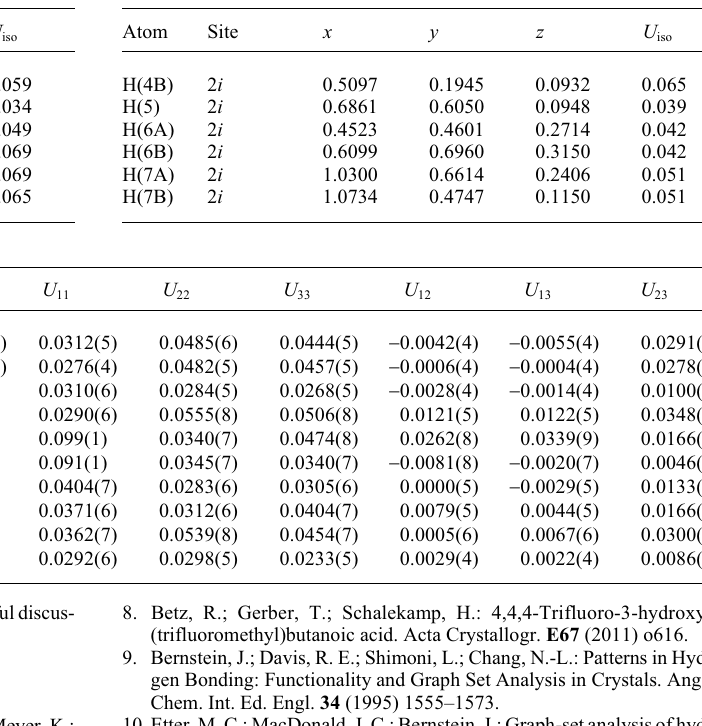
Table 2. Atomic coordinates and displacement parameters (in Å 2 ) . Table 2. continued